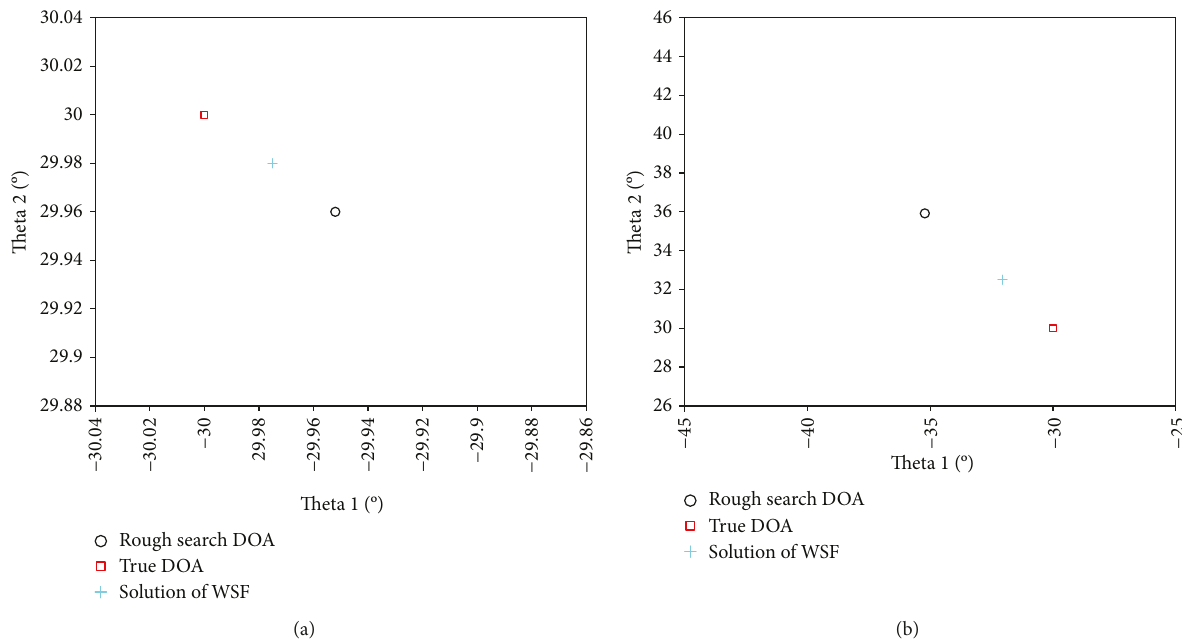
Figure 1: Positions of the solution of WSF, the true DOA, and the rough search DOA. (a) p = 8 , q = 2 , M = 100 , and SNR = 0 dB ; all the signals are independent (noncoherent). (b) p = 8 , q = 2 , M = 100 , and SNR = 0dB ; 2 signals are fully correlated